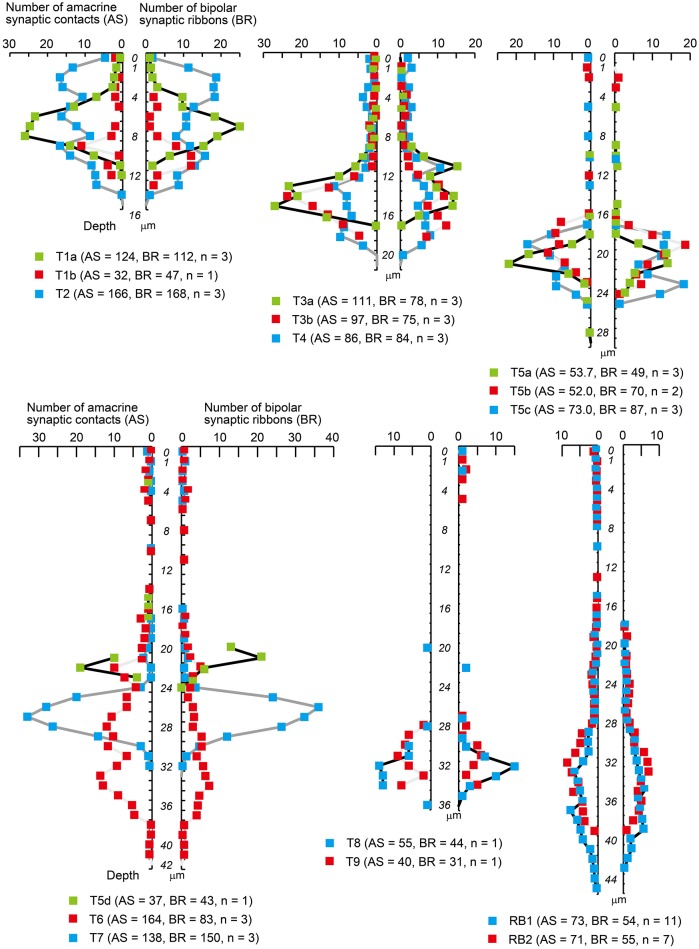
Density profiles of input amacrine cell synapses and output synaptic ribbons along the axon of each bipolar cell type. Only those points with positive values are designated with colored squares. The vertical axis shows the IPL depth with units of 1 μm; 0 indicates the extra bin above the INL–IPL border, 1 indicates the first bin from 0 to 1 μm, 4 indicates the fourth bin from 3 to 4 μm, and so on. The horizontal axis shows the mean number of amacrine synaptic contacts (AS, left) and bipolar axonal ribbons (BR, right) in each 1 μm bin. Numbers in underneath parentheses indicate the means of all amacrine synapses (AS) and all bipolar ribbons (BR) with the number of cells (n).